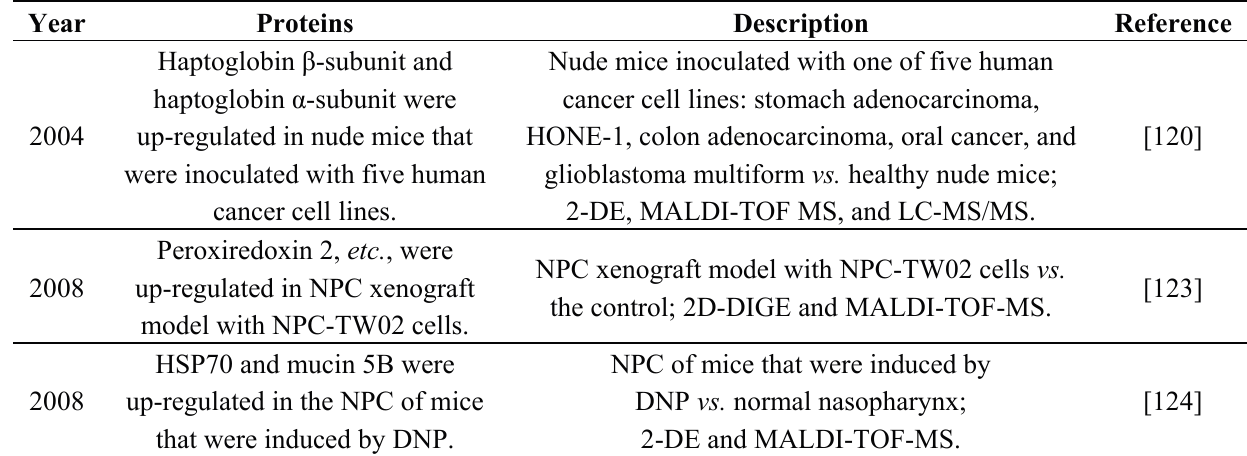
Table 2. The proteomics of mice xenotransplant models as related to nasopharyngeal